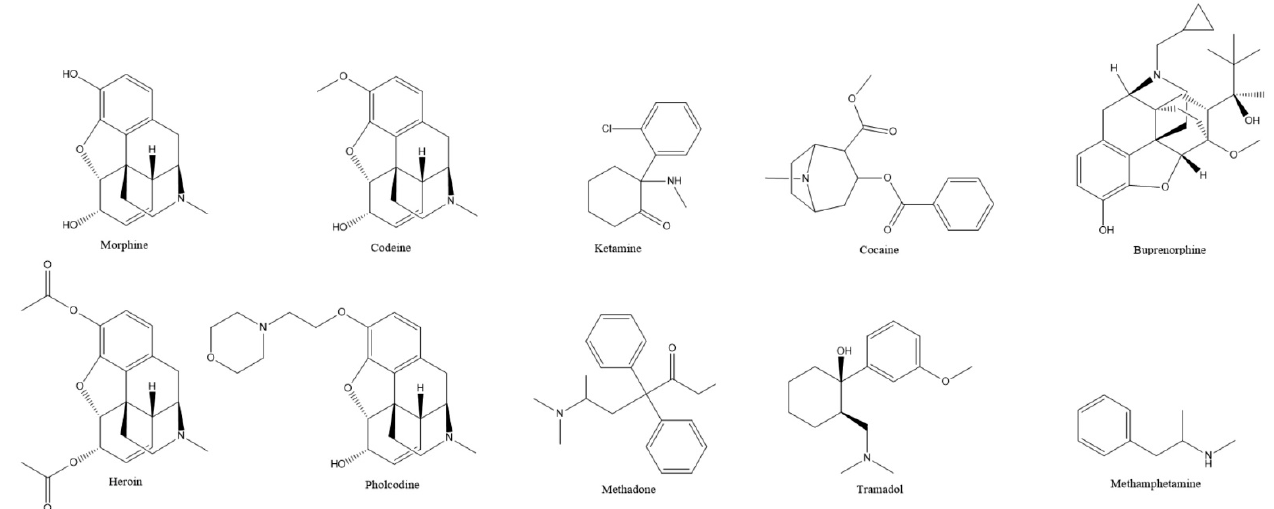
Figure 1. Molecular structure of the depressant and stimulant drugs studied in this review.